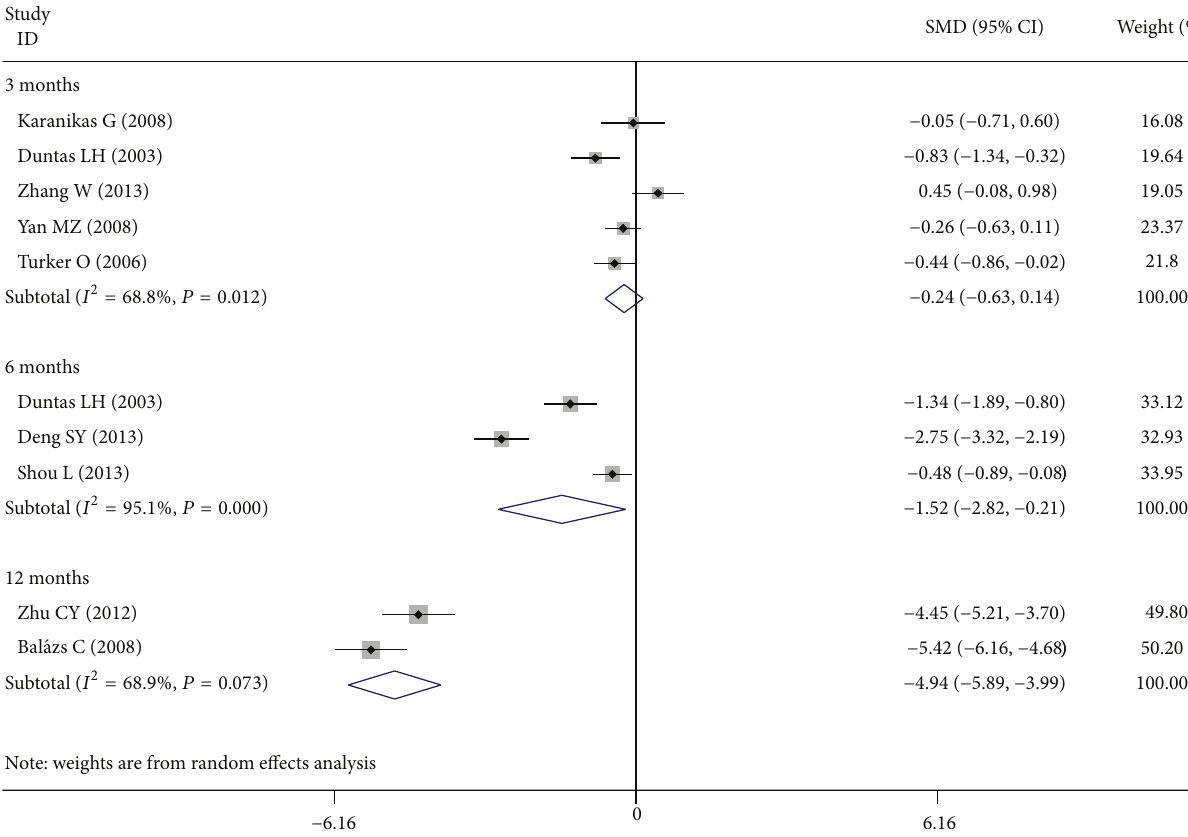
Figure 2: Forest plot showing the effects of Se supplementation on TPOAb titers in patients of AIT.